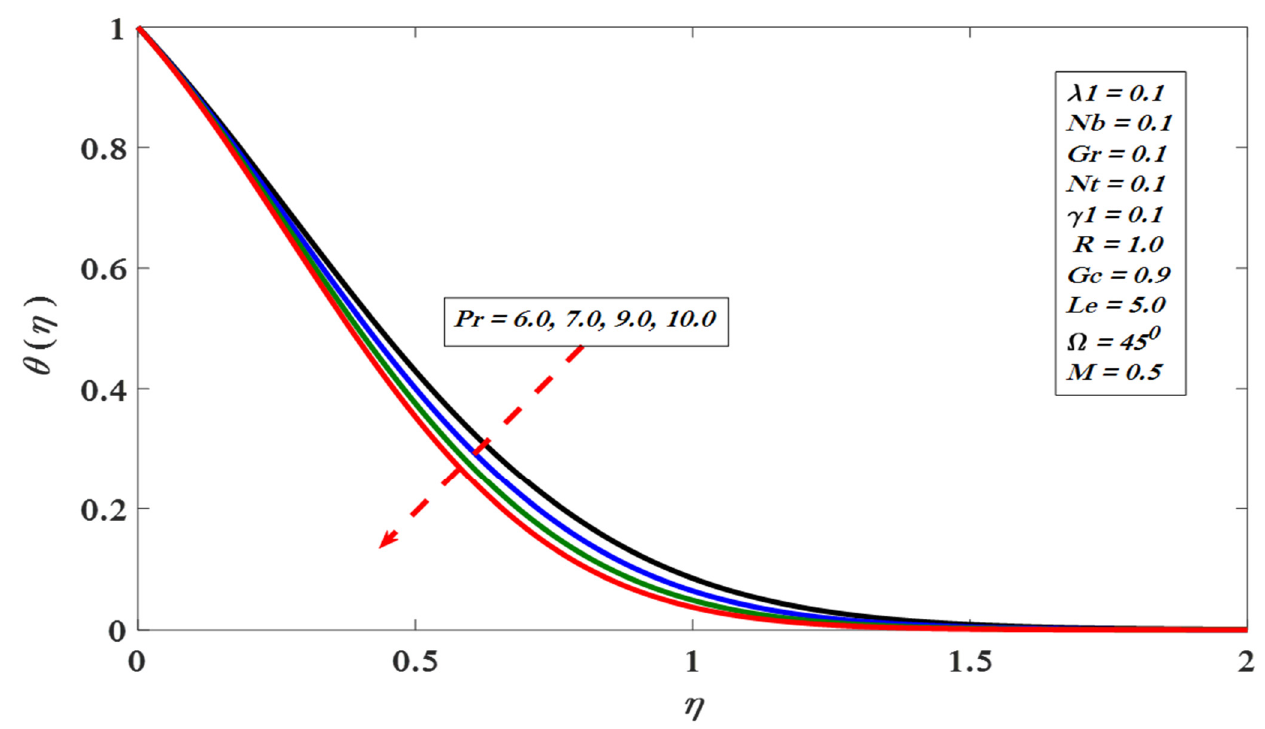
Figure 9. Temperature profile versus Pr.